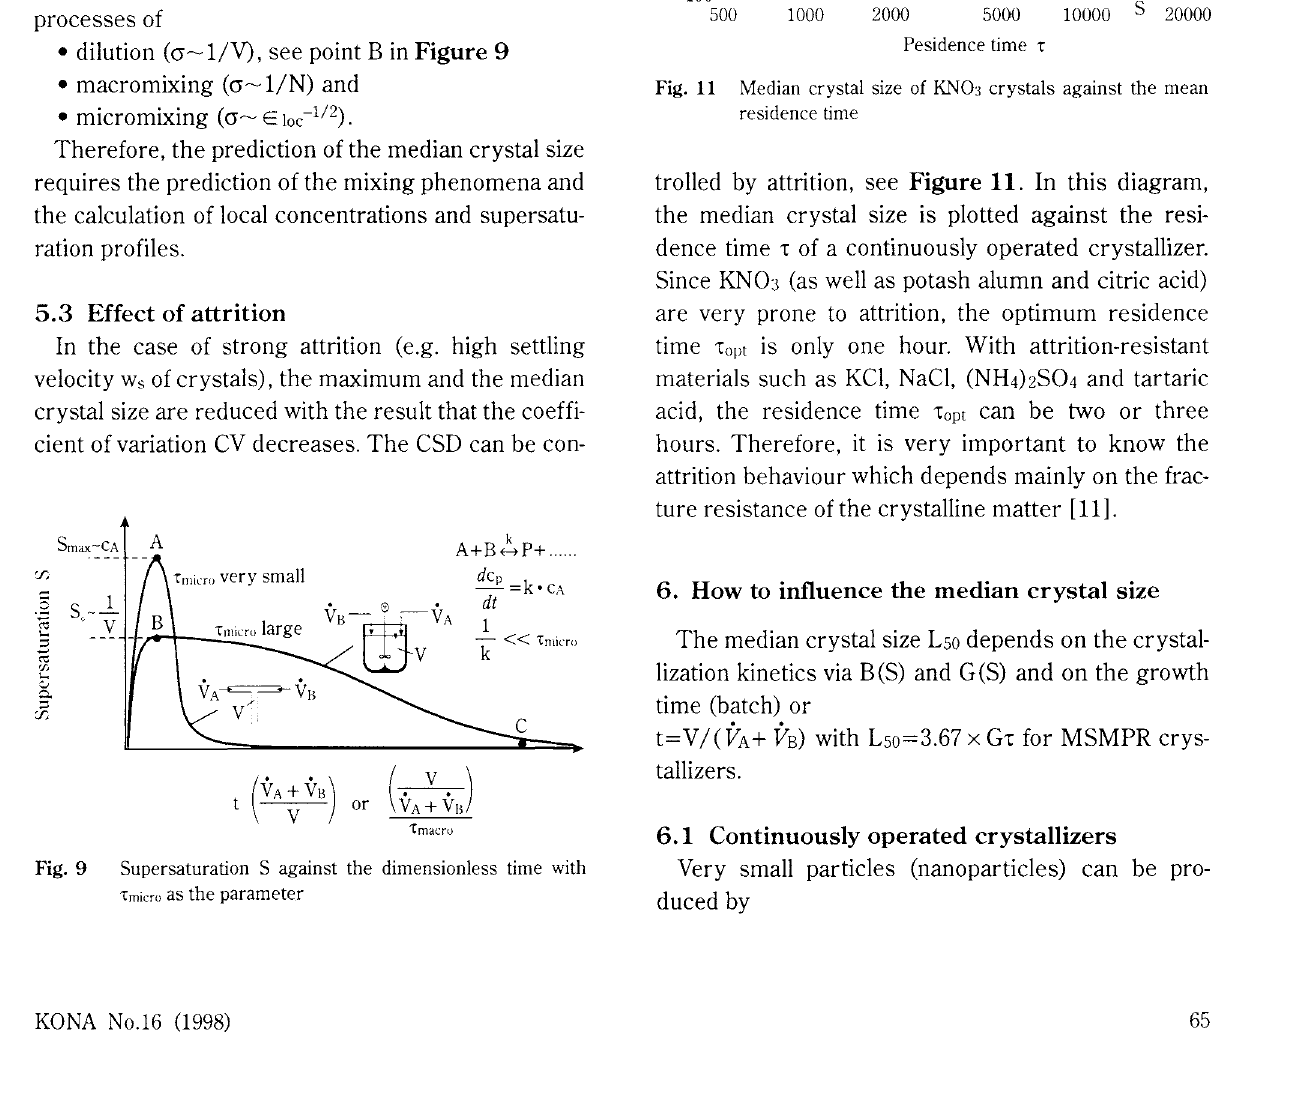
Fig. 10 Operation of aT-mixer and a stirred vessel